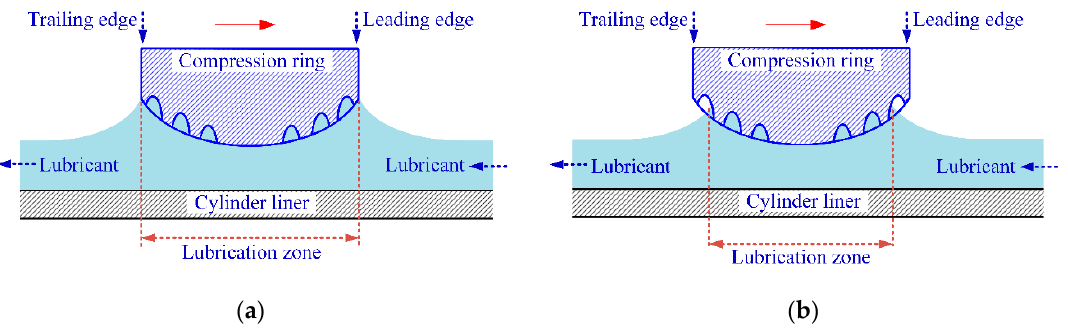
Figure 3. Schematic diagram of lubrication condition: ( a ) Fully flooded lubrication condition; ( b ) Starved lubrication condition.